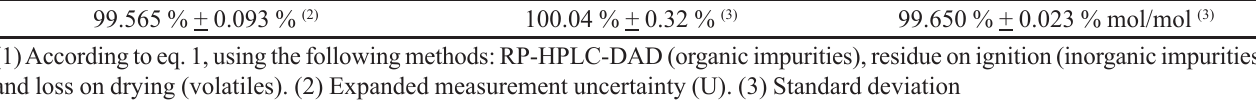
TABLE VII - Comparison of captopril contents determined by different methods for accuracy evaluation Mass balance